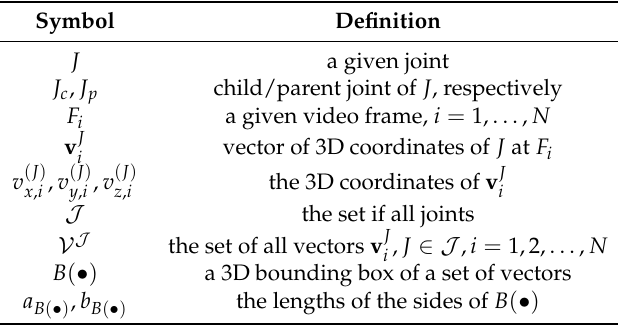
Table 2. Symbols used throughout this paper and their